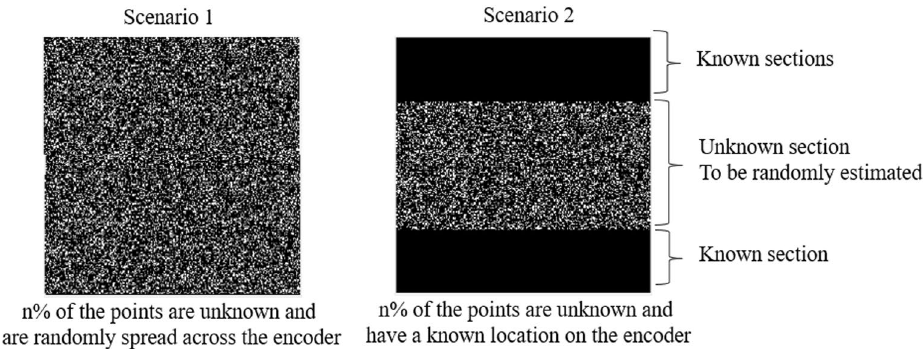
Figure 3. Example of the absolute difference between the original and the estimated encoder patterns at 50 % data validity for the two presented